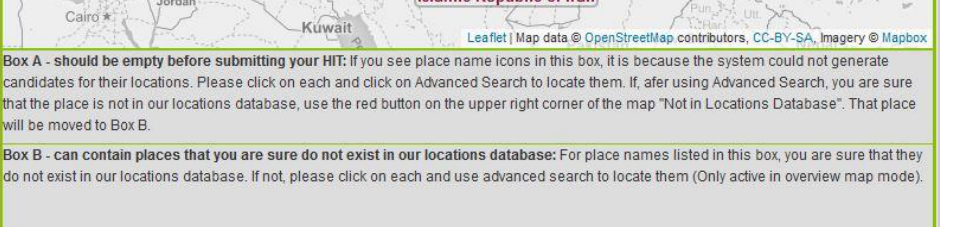
Figure 14. Geo-annotation after correction for the Black Sea and the Hindu Kush Mountains (which is now removed from box A under the map).